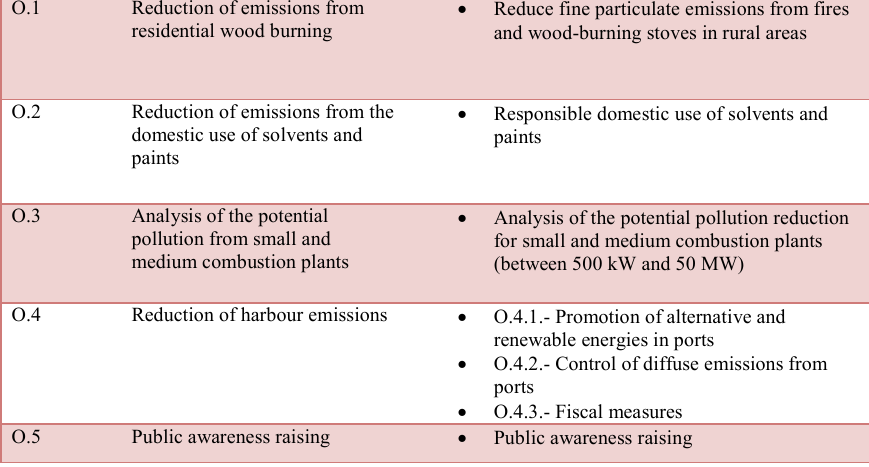
Figure A2. Target Measures (not included yet in the WAM2030 scenario emission reductions).